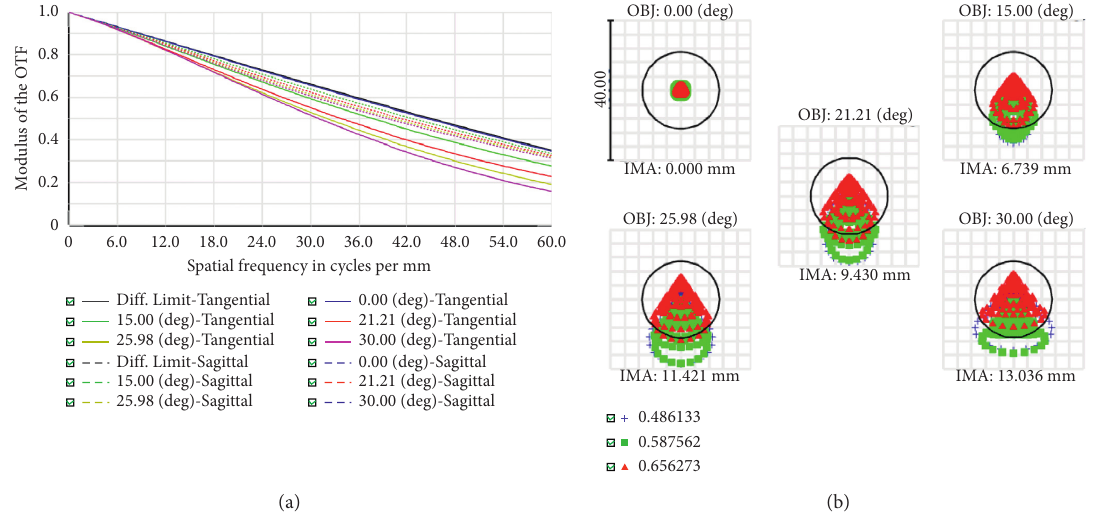
Figure 5: (a) An MTF view of a microlens with an MTF greater than 0.2 over the entire field of view at 60HZ. (b) Scatter plot showing spot size of lens near diffraction